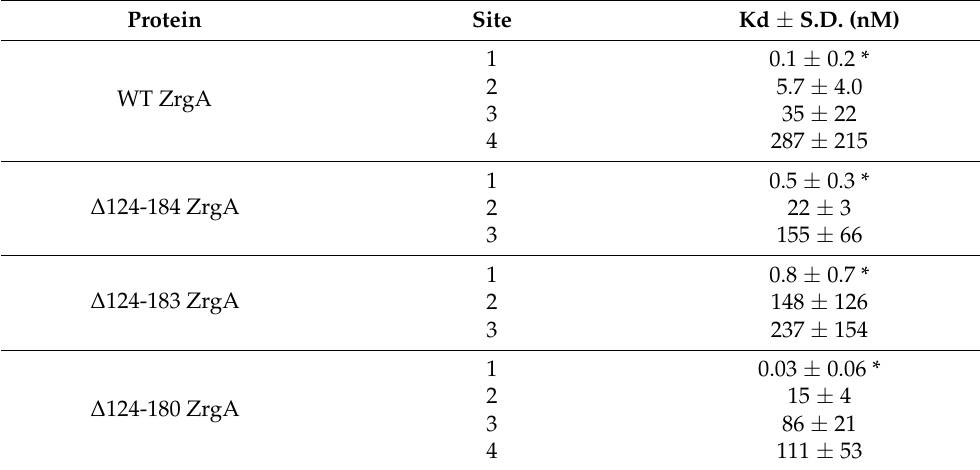
Figure 3. Competitive assay for zinc binding. MagFura-2 at 0.5 µ M in the absence (filled circles) or presence (empty circles) of 1.0 µ M WT ZrgA ( A ), ∆ 124-184 ZrgA ( B ), ∆ 124-183 ZrgA ( C ) or ∆ 124-180 ZrgA ( D ) was titrated with ZnCl 2 . The change in fluorescence intensity was tracked at 330 nm representing formation of the MF2-Zn complex and plotted against total added zinc. Each experiment was run in triplicate and error bars represent the standard deviation between experiments. Fits with parameters indicated in Table 1 are shown as solid lines. Table 1. Zinc binding affinity and stoichiometry of WT and mutant ZrgA. Uncertainties are ex- pressed as the standard deviations of fitted values for three independent experiments.